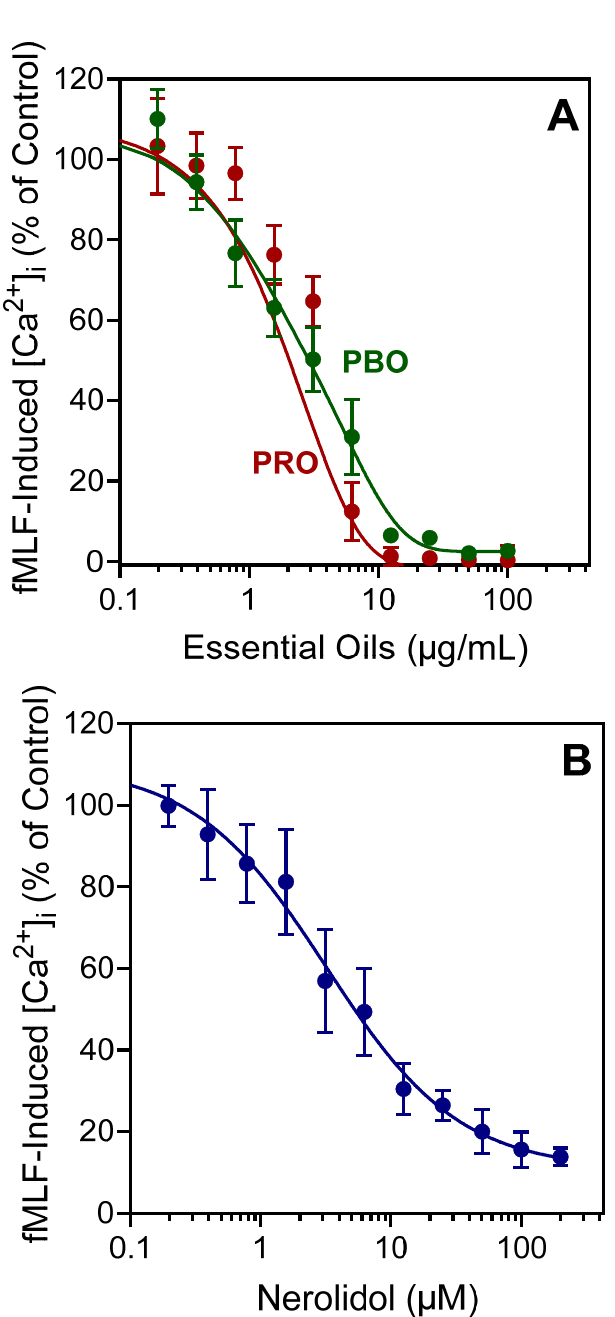
Figure 2. Effect of PBO, PRO, and nerolidol on f MLF-induced neutrophil [Ca 2+ ] i . Human neutrophils were treated with the indicated concentrations of the essential oils ( A ), nerolidol ( B ), or 1% DMSO (negative control) for 10 min. The cells were then activated with 5 nM f MLF, and [Ca 2+ ] i was monitored as described. The data shown are presented as the mean ± SD from one experiment that is representative of three independent experiments with similar results.